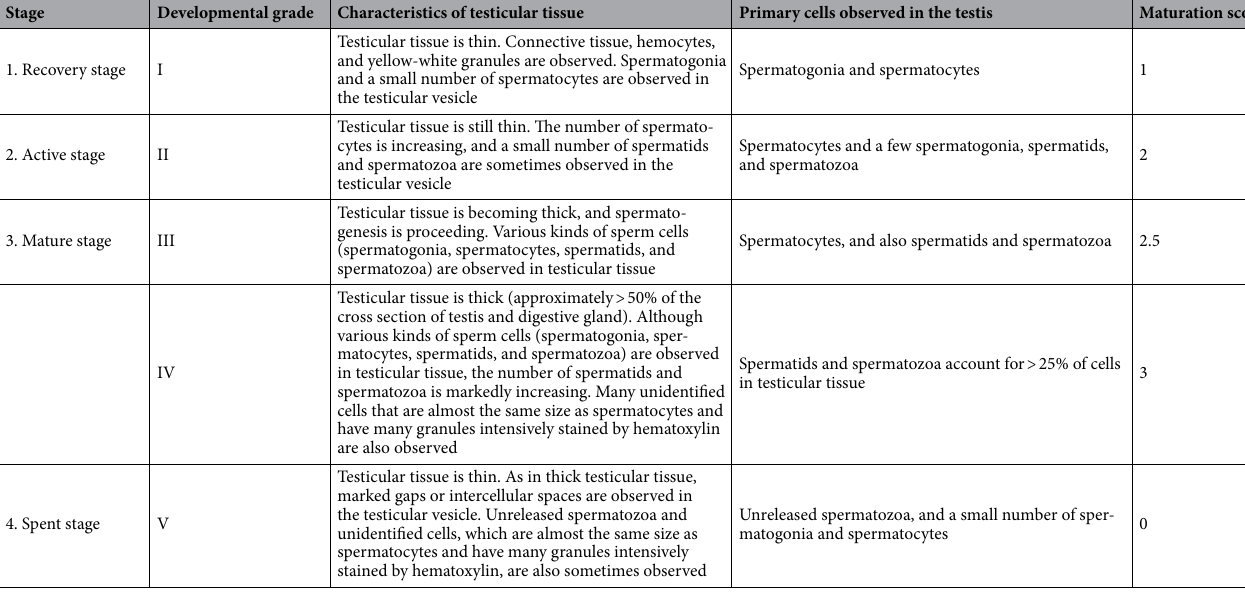
Table 2. Stages, developmental grades, and maturation scores of testes of Thais clavigera and Thais bronni